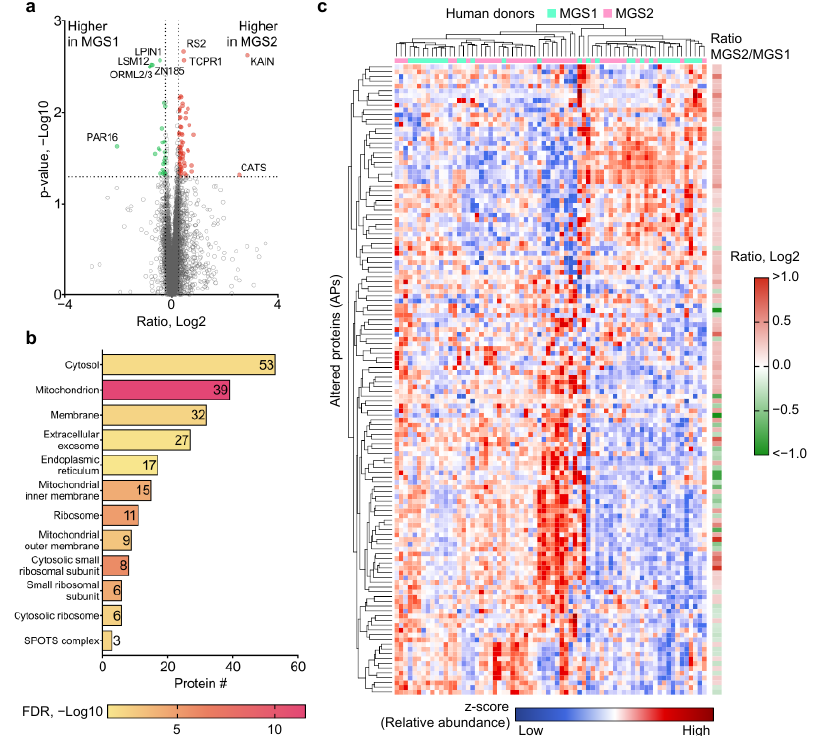
Figure 4. Determination of RPE proteome-wide changes between early AMD donors (i.e., MGS2) and healthy controls (i.e., MGS1). ( a ) Volcano plot of protein ratios and p-values. A total of 132 proteins were statistically significant, among which 67 and 26 were up- and downregulated; ( b ) GO enrichment of cellular components terms for the altered proteins (APs). A total of 39 APs were enriched in the mitochondria term with high statistical significance; and ( c ) heatmap showing results from unsupervised hierarchical clustering of the 132 APs in individual samples.